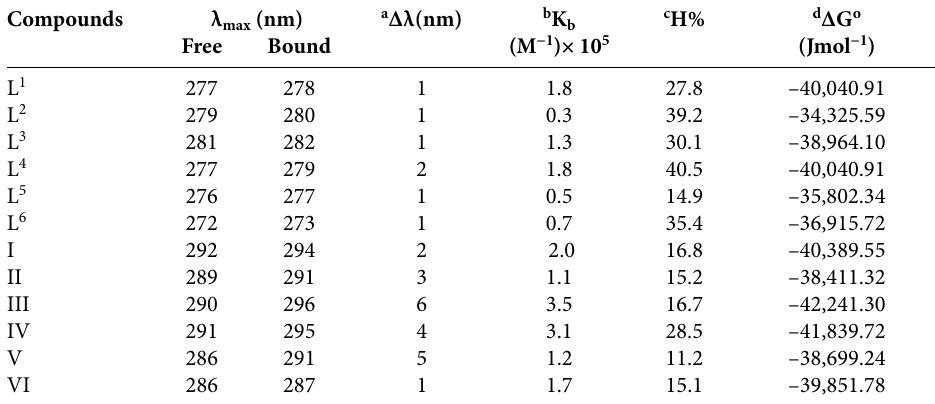
a Δλ = Difference between bound wavelength and free wavelength.; b K tion spectral titration; c H% = [(A free – A bound )/A free ] × 100%; d ΔG° = Change in Gibb’s free energy